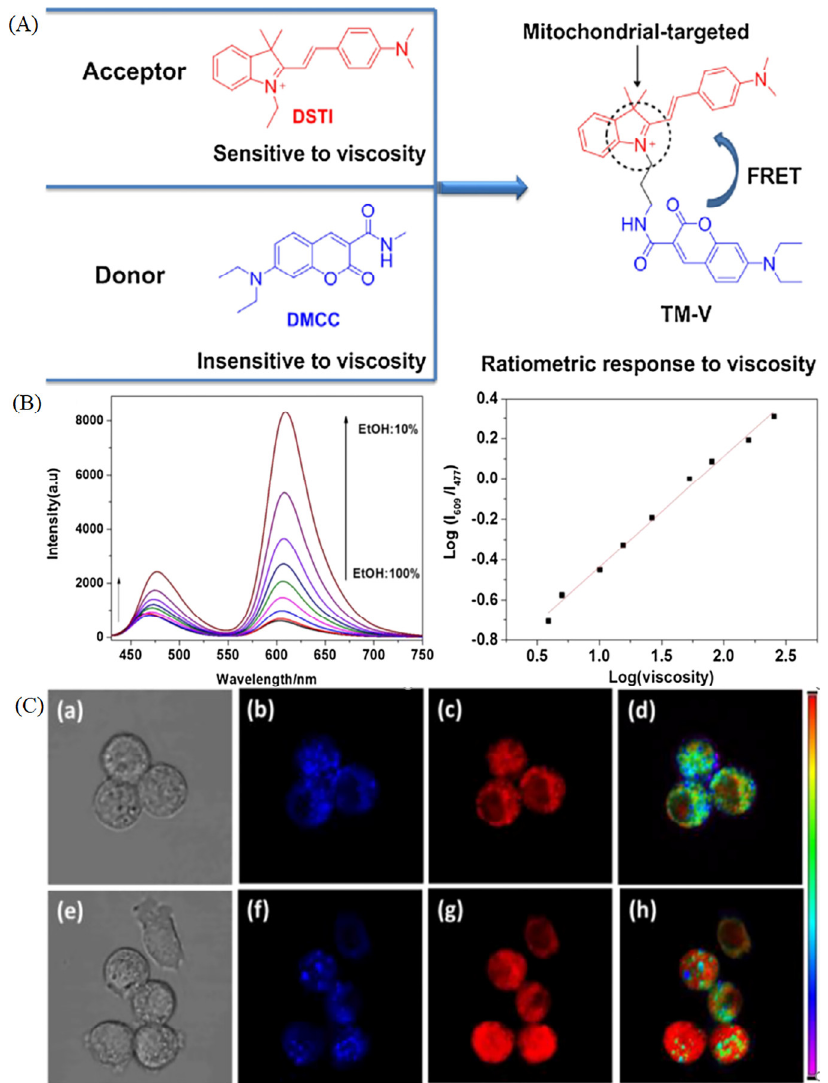
Figure 6. ( A )The design principle of probe (TM-V) for ratiometric visualize mitochondrial viscosity in FRET mechanism. ( B ) The fluorescence intensity spectra of TM-V (10 µM) in the solvents of ethanol ( E )–glycerol ( G ) mixtures under the exciting wavelength at 425 nm. ( C ) The bright field ( a , e ) and viscous fluorescence images ( f – h ) of TM-V (10 µM) in RAW 264.7 cells under normal stations ( b – d ) or treatment by PMA ( f – h ). Reproduced from Ref. [47] with permission of the Elsevier, copyright 2019.